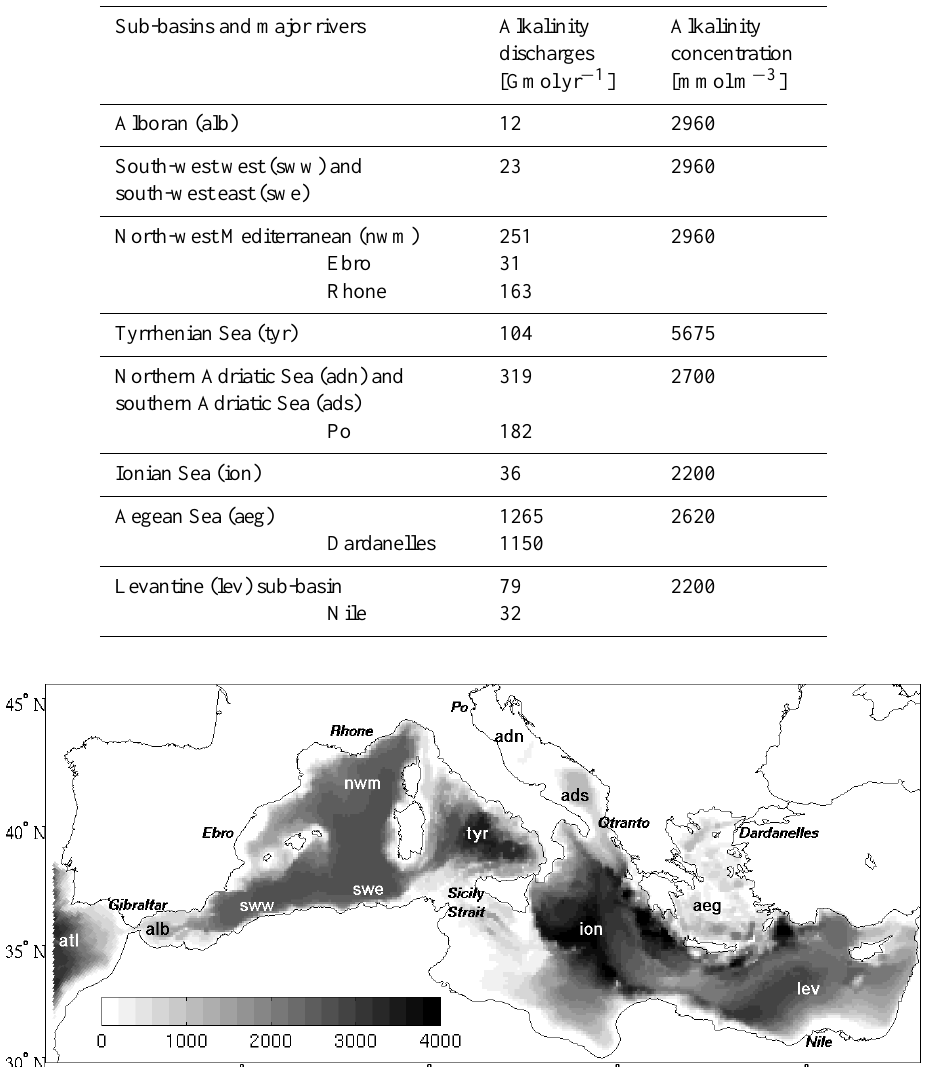
Table 2. Alkalinity mean annual discharges for the Mediterranean sub-basins and quota of the discharges due to major rivers (second column). Values of alkalinity concentration in the terrestrial input of the given sub-basins (third column) are derived from Copin-Montégut (1993).